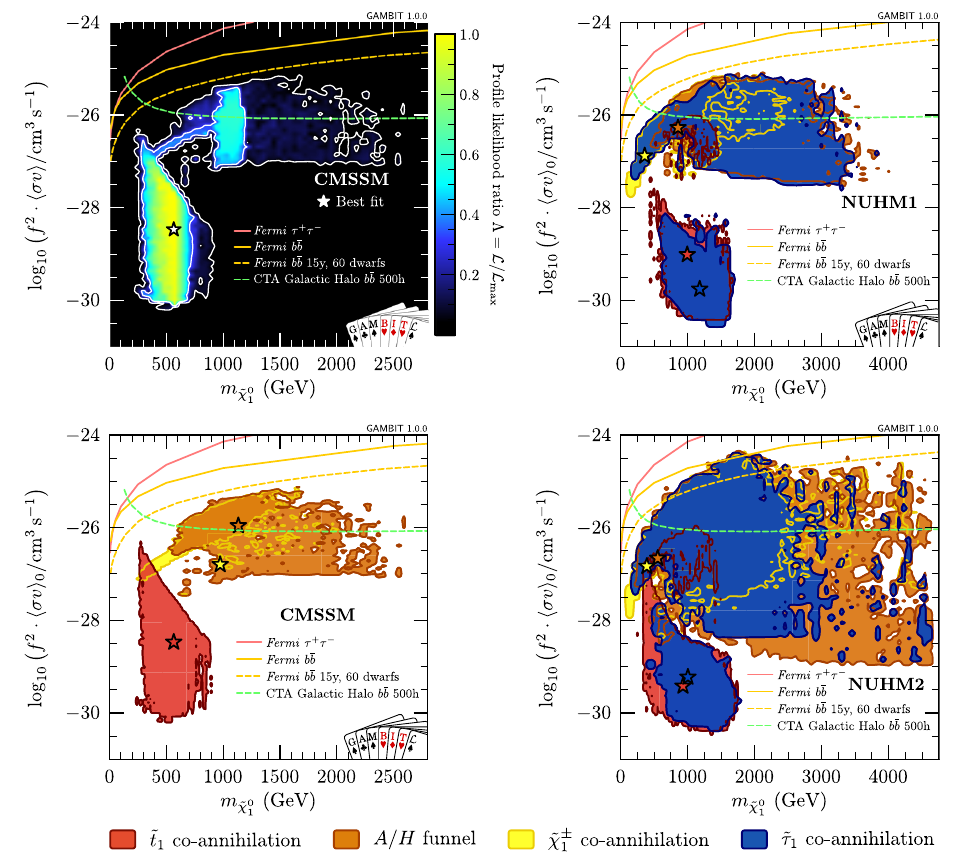
Fig. 21 The present-day neutralino self-annihilation cross-section. Upper left: Profile likelihood in the CMSSM. Bottom left: Colour- coding shows the active mechanism(s) by which CMSSM models avoid exceedingtheobservedrelicdensityofDM,througheithercharginoco- annihilation,the A / H funnel,orstopco-annihilation.Topright:Colour- coded regions in the NUHM1, now also featuring stau co-annihilation (blue). Bottom right: Colour-coded regions of the NUHM2. 95% CL exclusion limits are overlaid from the 6-year Fermi -LAT search for DM